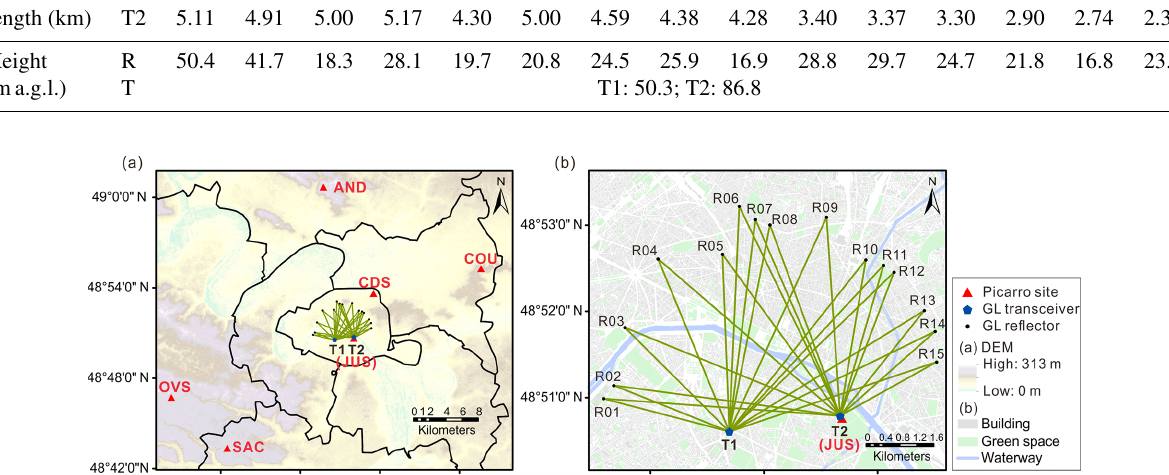
Figure 1. (a) Distribution of in situ CO 2 measurements and the GreenLITE ™ laser system. The city of Paris is located within the inner line, but the urban area extends over a larger surface, very roughly within the Greater Paris area (including Paris and the three administra- tive areas that are around Paris called “Petite Couronne” in French; see Fig. S5). The Île-de-France region covers an area that is larger than the domain shown here. (b) The GreenLITE ™ laser system layout and its chord labels. Data sources: the ASTER global digital elevation model (GDEM) Version 2 data are available at https://lpdaac.usgs.gov/products/astgtmv002/ (last access: 12 November